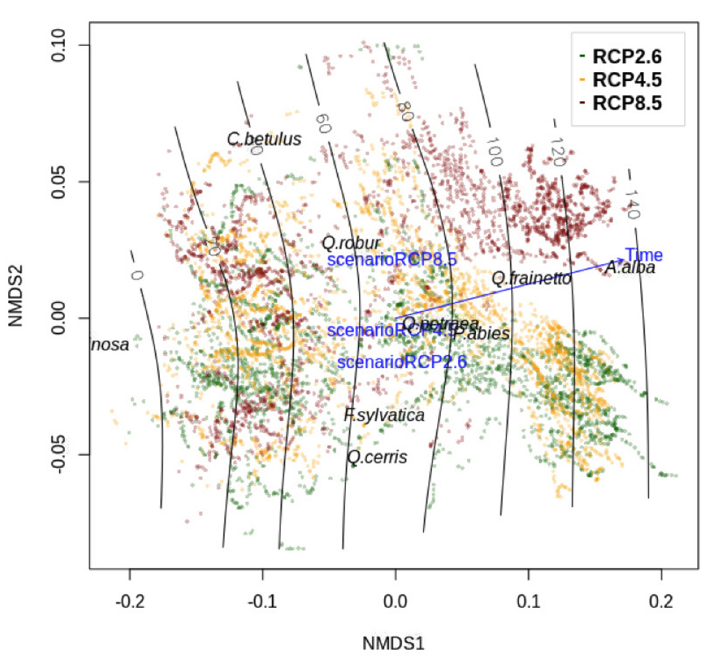
Figure 9. Ordination-based redundancy analysis of species biomass for the whole landscape, every RCP 2.6 (green), RCP 4.5 (orange) and RCP 8.5 (red), with the constraining variables year and RCP